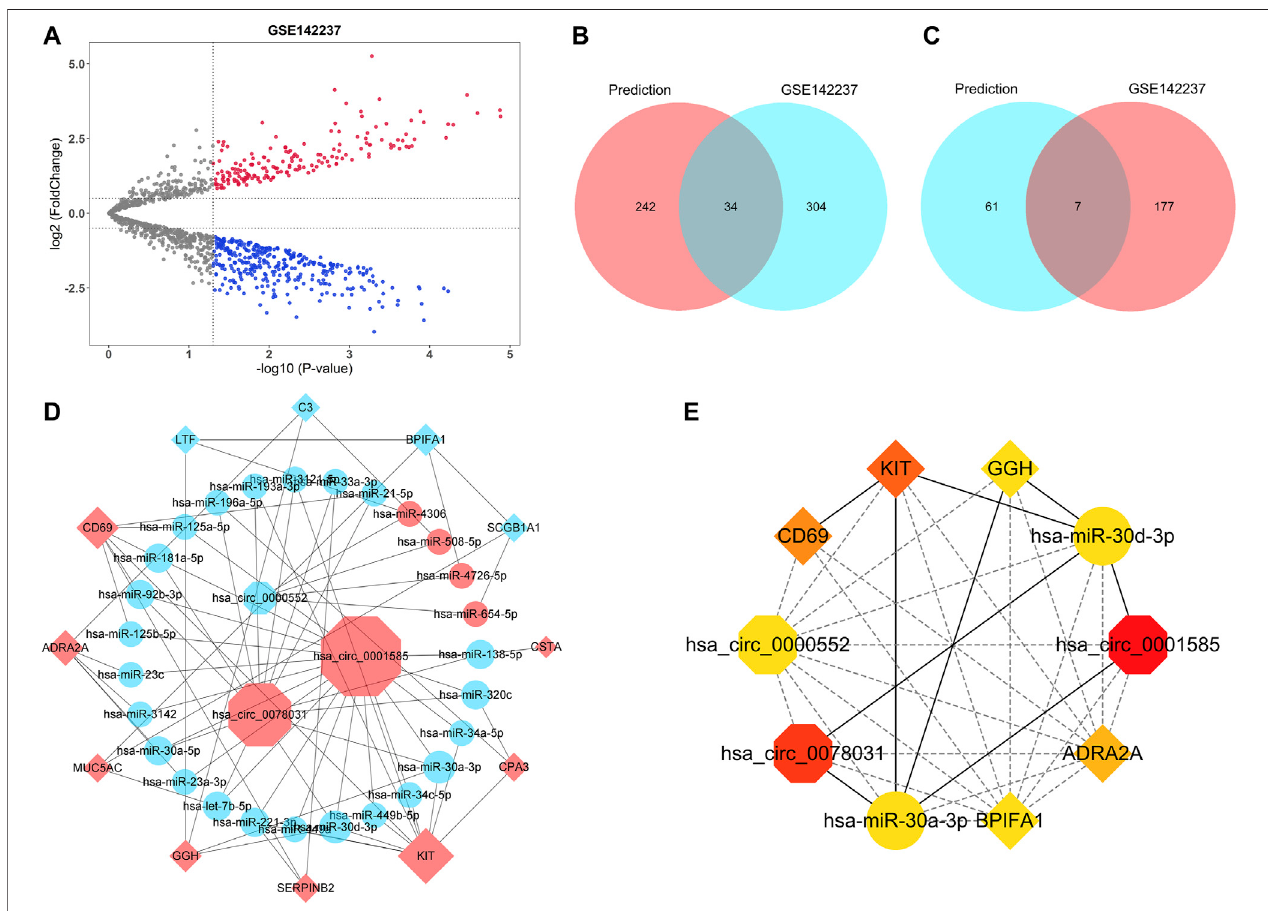
FIGURE7| CircRNA-miRNA-mRNAnetworkconstruction. (A) ThevolcanoplotofdifferentiallyexpressedmiRNAsofGSE142237.TheupregulatedmiRNAsweremarked in red, while the downregulated miRNAs were marked in blue. The gray dots represented miRNAs with no signi fi cant difference. (B) The Venn diagram showed the intersection between the miRNAs targeting upregulated hub genes in the prediction result (red) and the downregulated miRNAs of GSE142237 (blue). (C) The Venn diagram showed the intersection between the miRNAs targeting downregulated hub genes in the prediction result (blue) and the upregulated miRNAs of GSE142237 (red). (D) The circRNA- miRNA-mRNA network. CircRNAs were marked as octagons, miRNAs were marked as ellipses, and mRNAs were marked as diamonds. The size of the nodes indicated the degreeoftheconnection.Up-regulatedmoleculesweremarkedinred,whiledown-regulatedmoleculesweremarkedinblue. (E) Thetop10rankedceRNAsidenti fi edbyMCC algorithms. CircRNAs, miRNAs, and mRNAs were marked as octagons, ellipses, and diamonds, respectively. The colors of nodes represented the degree of the connection.